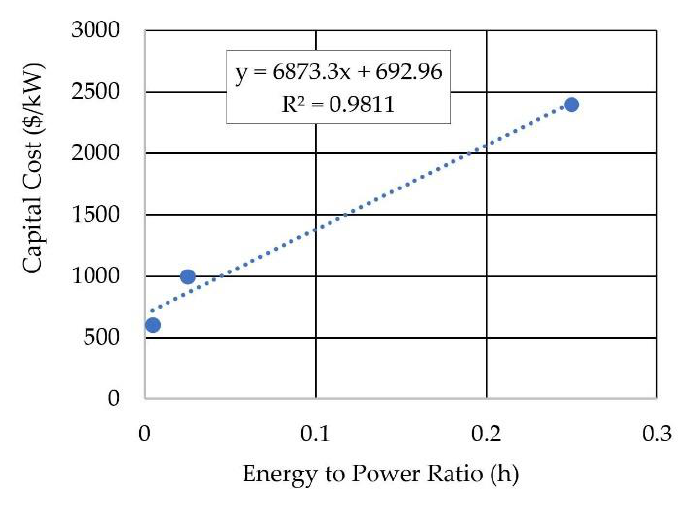
Figure 3. Capital Cost by energy-to-power ratio (h).